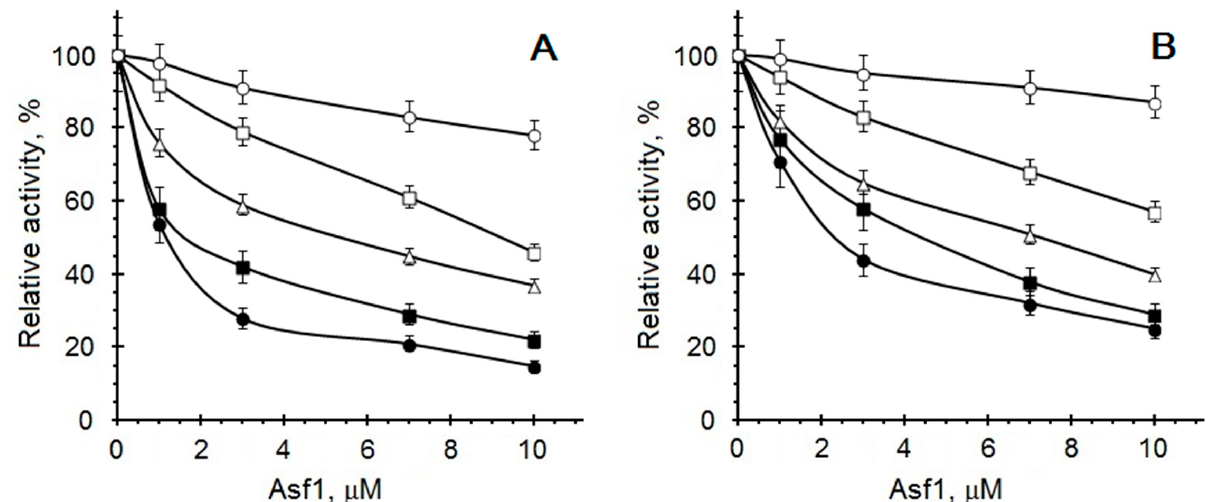
Figure 4. Comparison of substrate phosphorylation by CK2 α ’ ( A ) and CK2 α ( B ) in the presence of different Asf1 concentrations. Enzyme activity was measured using the following protein substrates: Elf1 ( ∆ ), Fip1 ( ■ ), Svf1 ( □ ), synthetic peptide ( ○ ), and P2B ( ● ). The experiment was carried out in the presence of 10 µM of protein substrate and 20 µM ATP. Relative activity is calculated towards enzyme activity in the absence of Asf1.